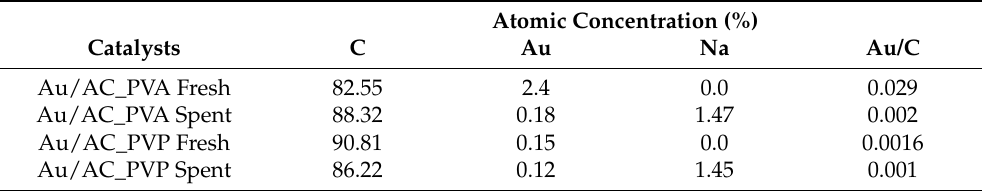
Table 3. XPS atomic concentration of the components for the fresh and spent Au/AC_PVA and Au/AC_PVP